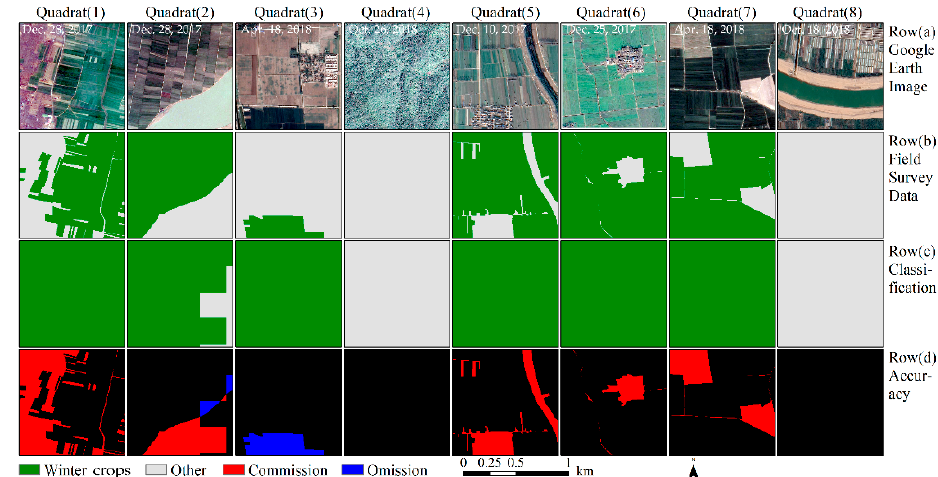
Figure 9. Accuracy assessment of winter crop classification results, based on MODIS images. The eight blocks were selected randomly from 62 validation blocks. Row (A): The Google Earth image, with a spatial resolution of 1 m. Row (B): The ground truth data, with a spatial resolution of 3 m. Row (C): The extracted winter crops, using the methods proposed in this study. Row (D): Accuracy assessment. Black indicates correct classification, red indicates commission errors, and blue indicates omission errors for winter crop classification.